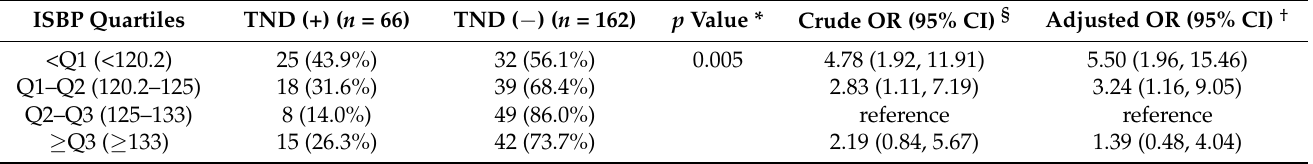
Table 2. Occurrence of TND according to ISBP quartiles.